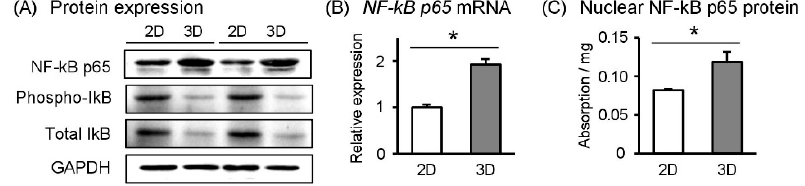
Figure 2. Effects of 3D culture conditions on NF- κ B system in Sw.71 cells. Sw.71 trophoblast cells were incubated for 24 h in 2D or 3D culture plates. ( A ) NF- κ B p65, phosphor I κ B, total I κ B, and